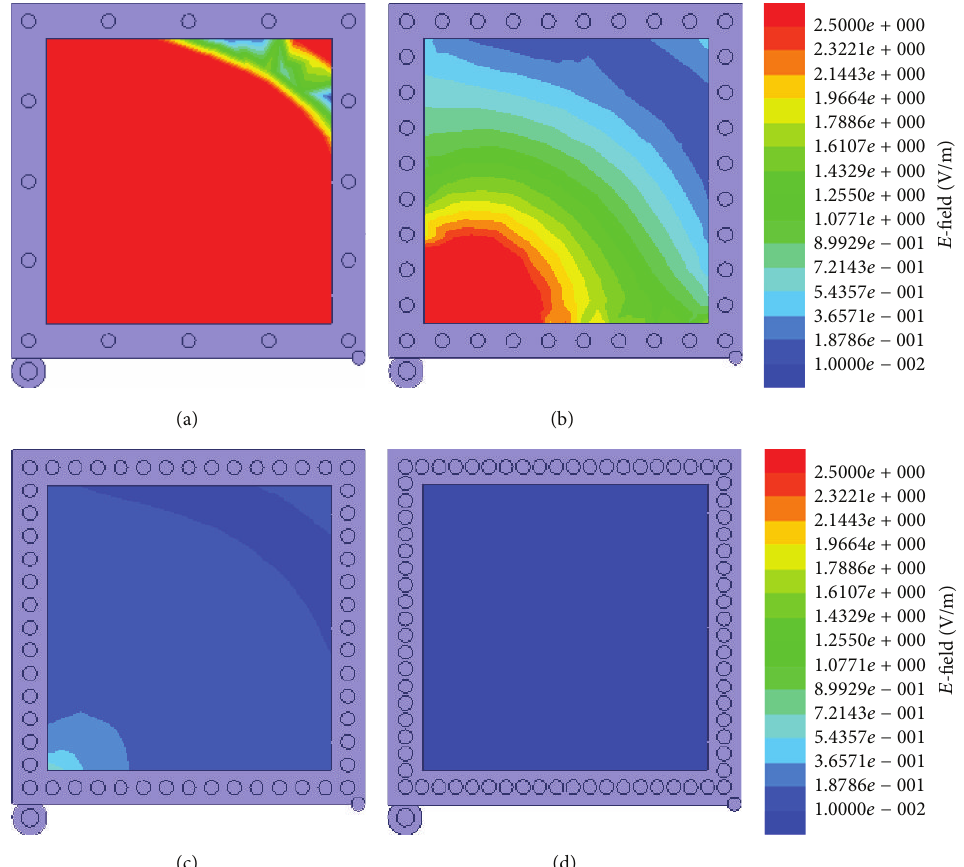
Figure 8: Electric field intensity distribution in the package cavity versus different number of the grounded vias, (a) 16, (b) 36, (c) 56, and (d) 76.